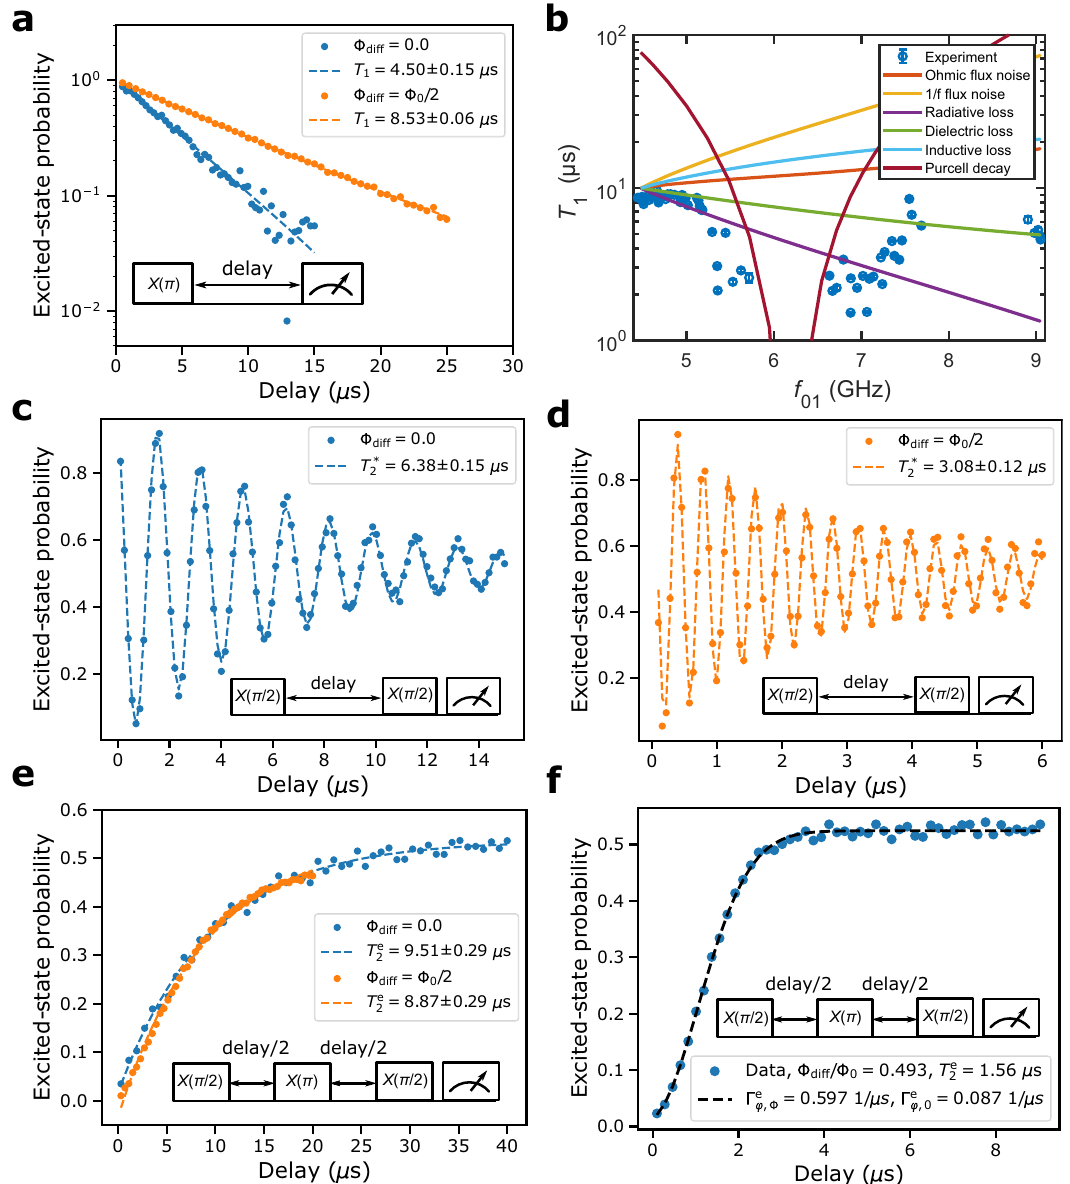
0.20.40.60.8 14 Delay ( s) Fig. 8 | Energy relaxation and coherence for qubit B. a Excited-state probability between the X ( π /2) pulses of a Ramsey measurement (see inset) conducted at Φ as a function of the delay time between the state preparation and readout (see diff =0usingadetuningof0.6MHzbetweenthedriveandqubitfrequencies. d As c but for Φ diff = Φ 0 /2 and a detuning of 2.5 MHz. e Measured excited-state prob- inset) at fl ux biases Φ diff =0 (blue color) and Φ diff = Φ 0 /2 (orange color). The exponential fi ts (dashed lines) yield energy relaxation times T 1 =4.5±0.2 μ s and ability (markers) as a function of the delay time between the X ( π /2) pulses in a T 2 echo measurement (see inset) conducted at the sweet spots Φ diff =0 (blue color) T 1 =8.5±0.1 μ sat Φ diff =0and Φ 0 /2,respectively. b Measuredmean T 1 asafunction of the qubit frequency f 01 (blue circles) and its theoretical predictions from dif- and Φ diff = Φ 0 /2(orange color). The dash linesprovide exponential fi ts to the data. f As e but for Φ diff / Φ 0 =0.493.Here, the dashed line shows a model corresponding ferentindicatedlossmechanismsthatarescaledtocoincidewiththeexperimental data at Φ diff = Φ 0 /2 excluding Purcell decay. The error bars provide the standard toaproductofaGaussianandanexponentialwithdecayrates Γ e φ , Φ =0 : 60 μ s (cid:2) 1 and : 09 μ s (cid:2) 1 , Γ e errorofthemeanbasedon6 – 30repeated T 1 measurements. c Measured(markers) φ ,0 =0 and fi tted (dashed line) excited-state probability as a function of the delay time